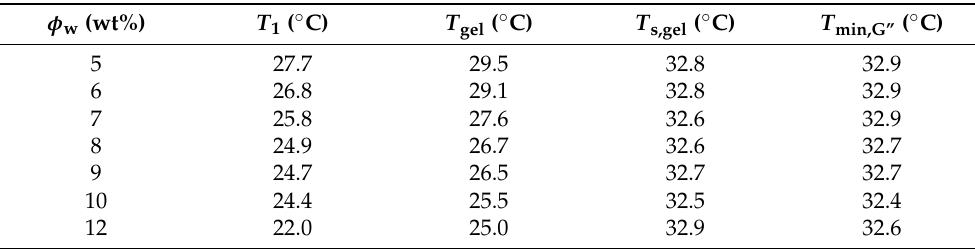
Table 1. Transition temperatures of a-PNIPAM aqueous solutions with different concentrations derived from the rheological measurements.